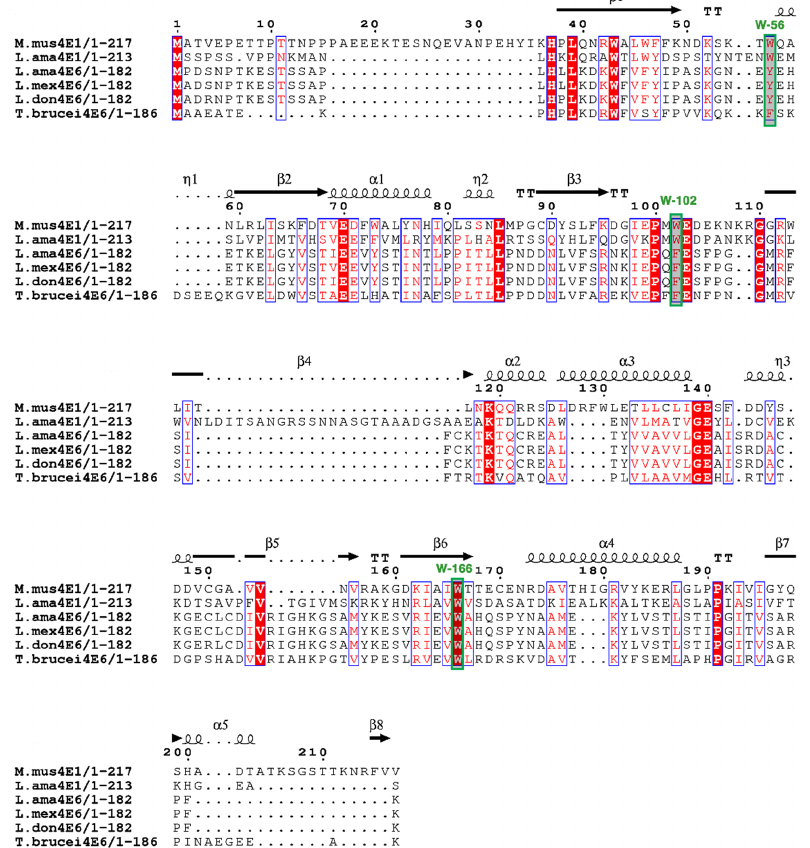
Figure 1. Multiple sequence alignment of the LeishIF4E-6. The open reading frames of eIF4E-6 from different Leishmania species and T. brucei along with mammalian and L. amazonensis LeishIF4E-1 were aligned using Jalview (2.10.5). The se- quences were retrieved from Mus musculus eIF4E-1 (ENSMUSG00000028156), L. amazonensis LeishIF4E-1 (LAMA_000544700), L. amazonensis LeishIF4E-6 (LAMA_000504800); L. mexicana LeishIF4E-6 (LmxM.26.0240) L. donovani LeishIF4E-6 (LdBPK.26.2.000230) and T. brucei TbIF4E-6 (Tb927.7.1670). The alignment file was saved in FASTA format. The final alignment showing the predicted secondary structure was developed using the downloaded PDB file (6YLT, doi: 10.2210/pdb6YLT/pdb) of Mus musculus eIF4E-1 (https://www.rcsb.org/structure/6YLT, 5 July 2021) along with the FASTA alignment file, using the online ESPript 3 tool. Symbols for the secondary structure elements were ( α : alpha helices, ƞ : 3 10 - helix, β : beta-strands, TT: strict β -turns). White letters over a red background correspond to identical residues while red letters over a white background correspond to similar residues.